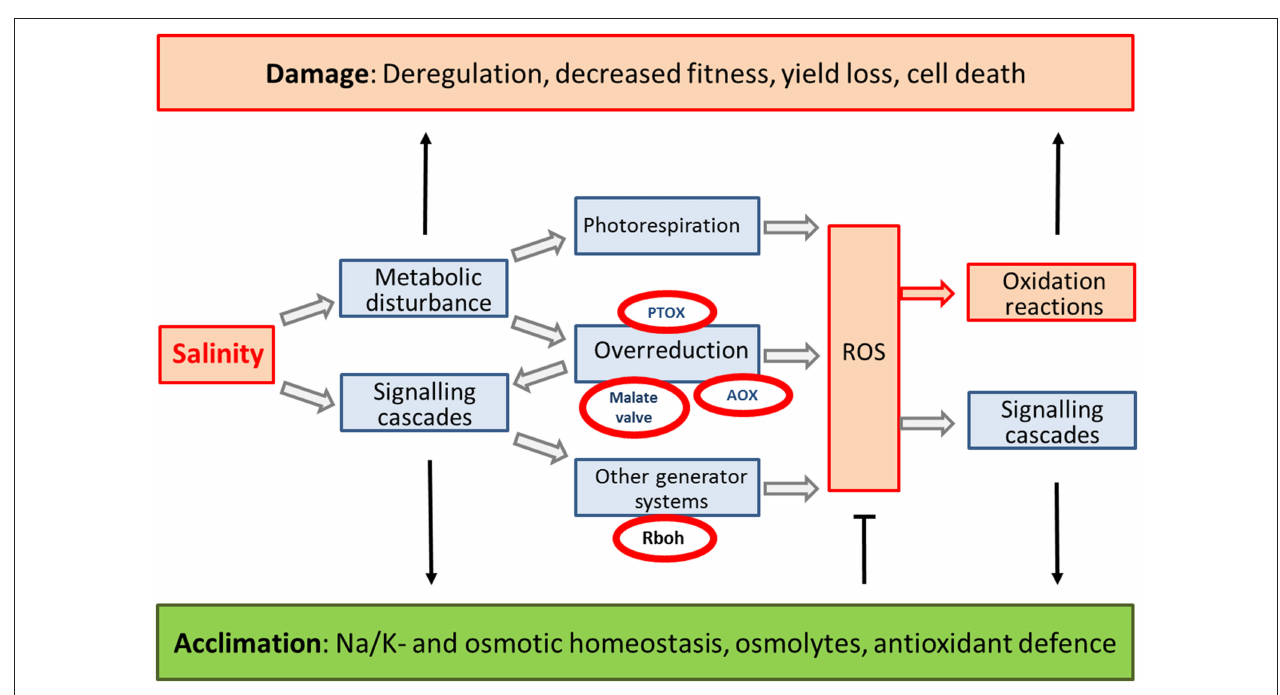
FIGURE 4 | Circuitry of redox and ROS-related events in salinity stress response. Salinity stress causes metabolic imbalances and activates signaling pathways. The metabolic imbalances increase the ROS generation e.g., by enhanced photorespiration or cause overreduction of PET and RET as described in the review. The latter is modulated by AOX, PTOX and malate valve. Signaling activates RBOH. Accumulating ROS either cause excessive oxidation reactions leading to damage or via redox- and ROS-dependent signaling and regulation allow for proper